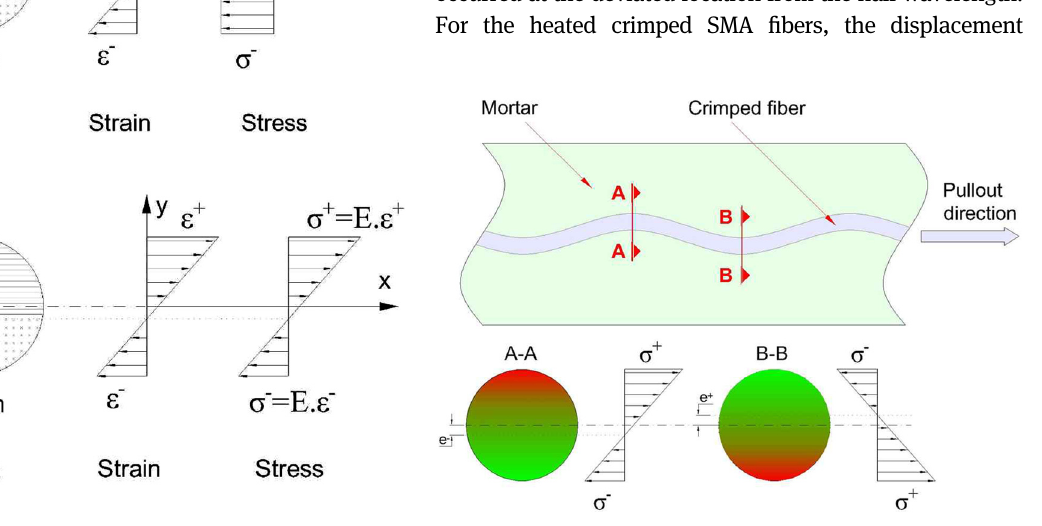
Figure 11: Stress and strain distribution of bent fi bers subjected to tension: ( a ) plastic bent fi ber [ 34 ] and ( b ) elastic bent fi ber.